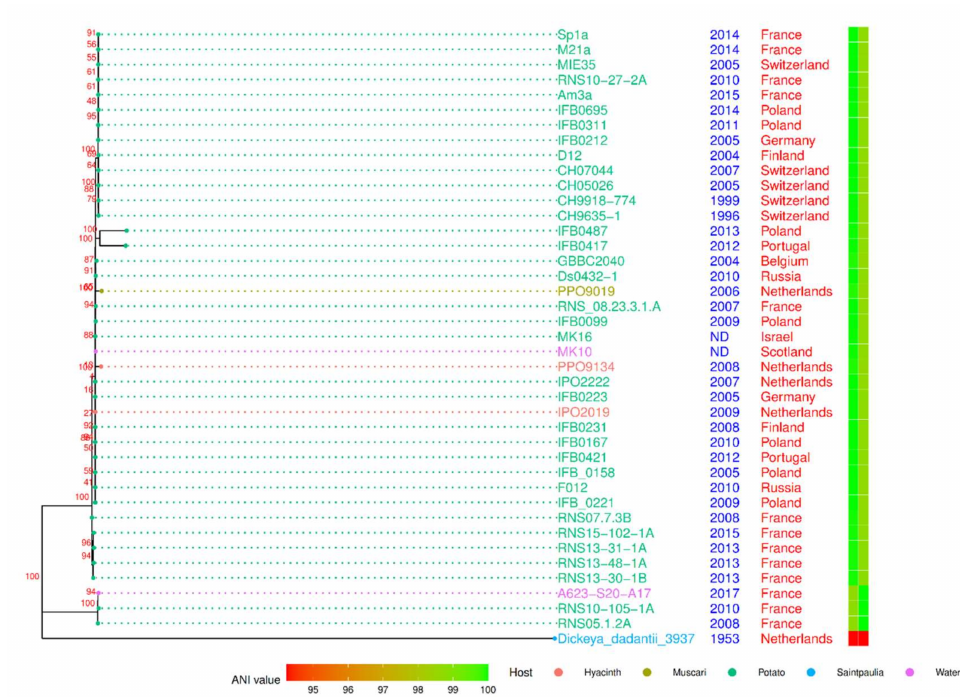
Figure 3. Core-genome maximum-likelihood phylogenetic tree of 40 D. solani strains. D. dadantii 3937 was used as an outgroup. The tree was inferred from an alignment of 3181 protein sequences for each strain. The date and geographical location of isolation of the D. solani strains are men- tioned. The heatmap indicates ANI value calculated against the strains RNS08.23.3.1.A ( left ) and RNS05.1.2A ( right